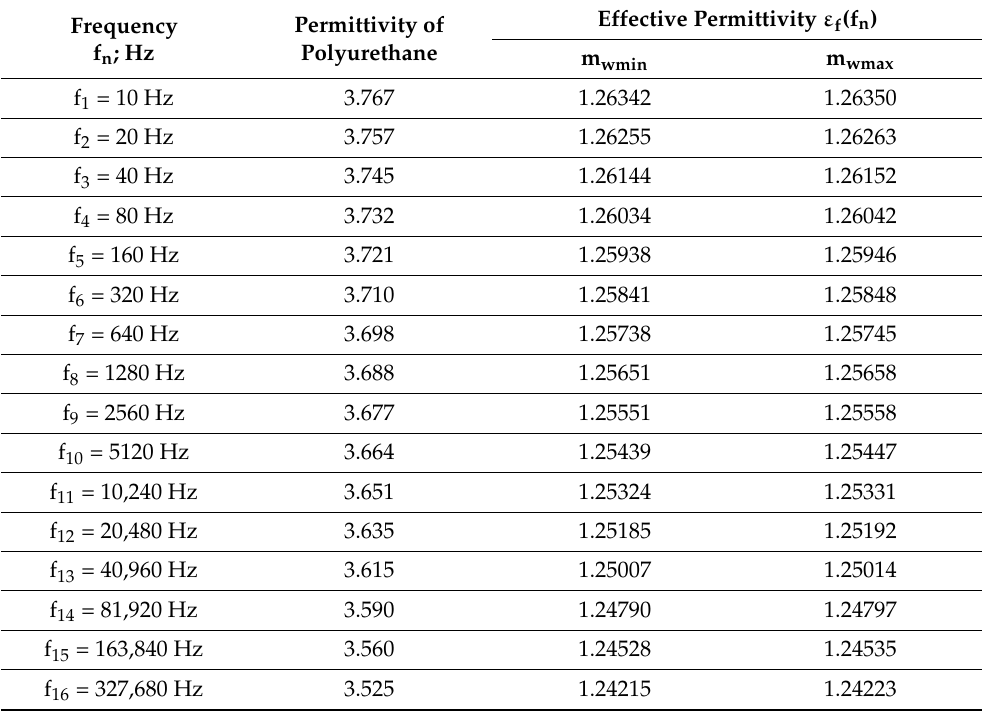
Table 6. The effective permittivity of open-cell PU SikaBlock ® -M150 foams (density of 144 kg/m 3